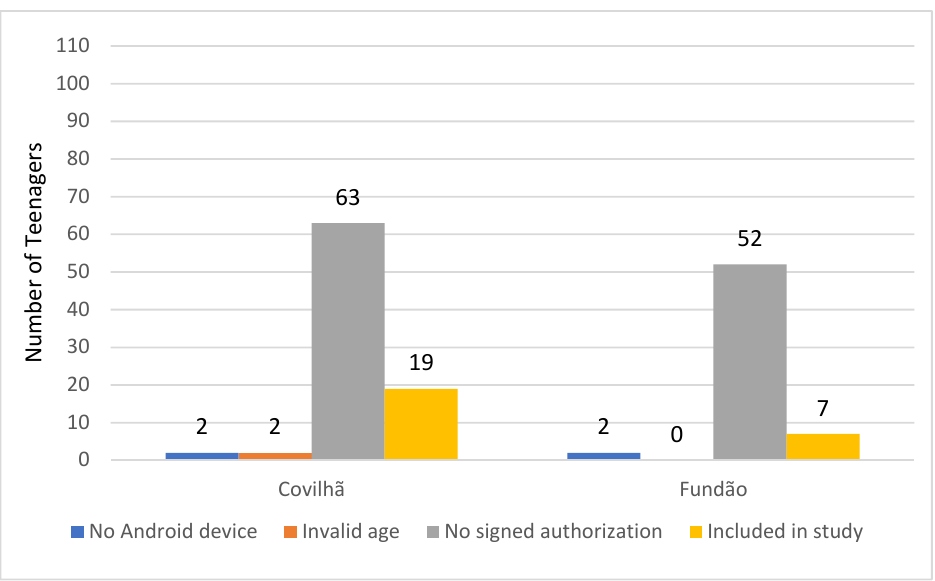
Figure 1. Selection process of the participants in the study from two schools.